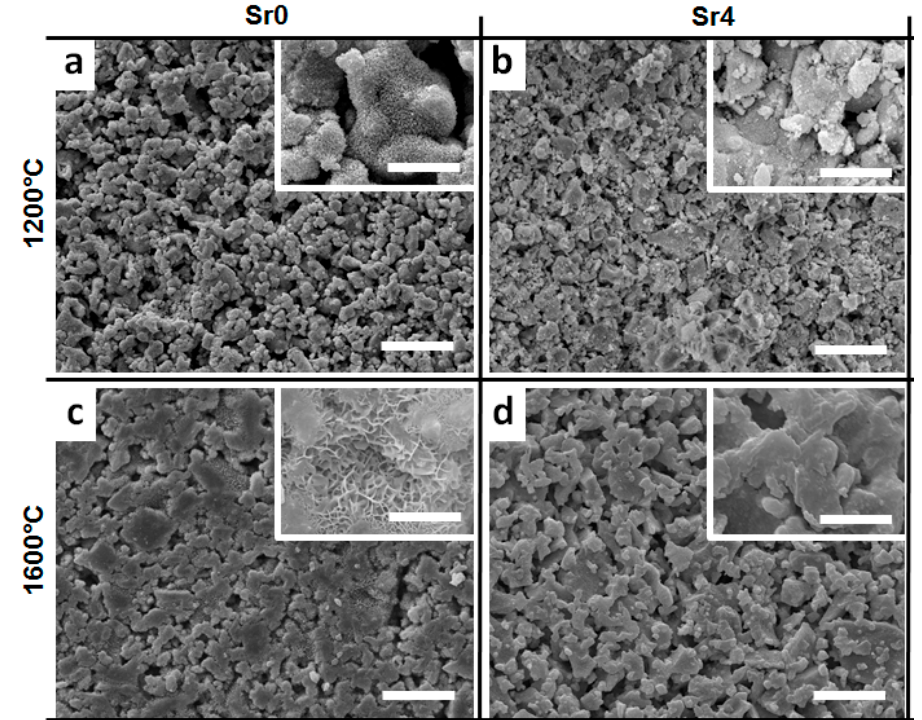
Figure 2. XRD patterns of Sr0, Sr2, and Sr4 powders prepared ( a ) and the correspondent Sr-containing apatite (SrHA) cements after 7 days of immersion in SBF at 37 °C ( b ). Peaks legend: α -TCP (X), β -TCP (•), CDHA (o).